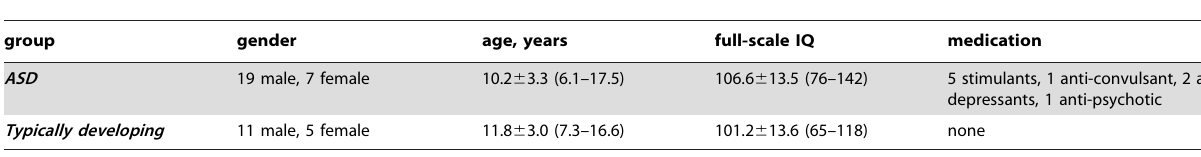
Table 3. Experiment 2: Subject group characteristics.